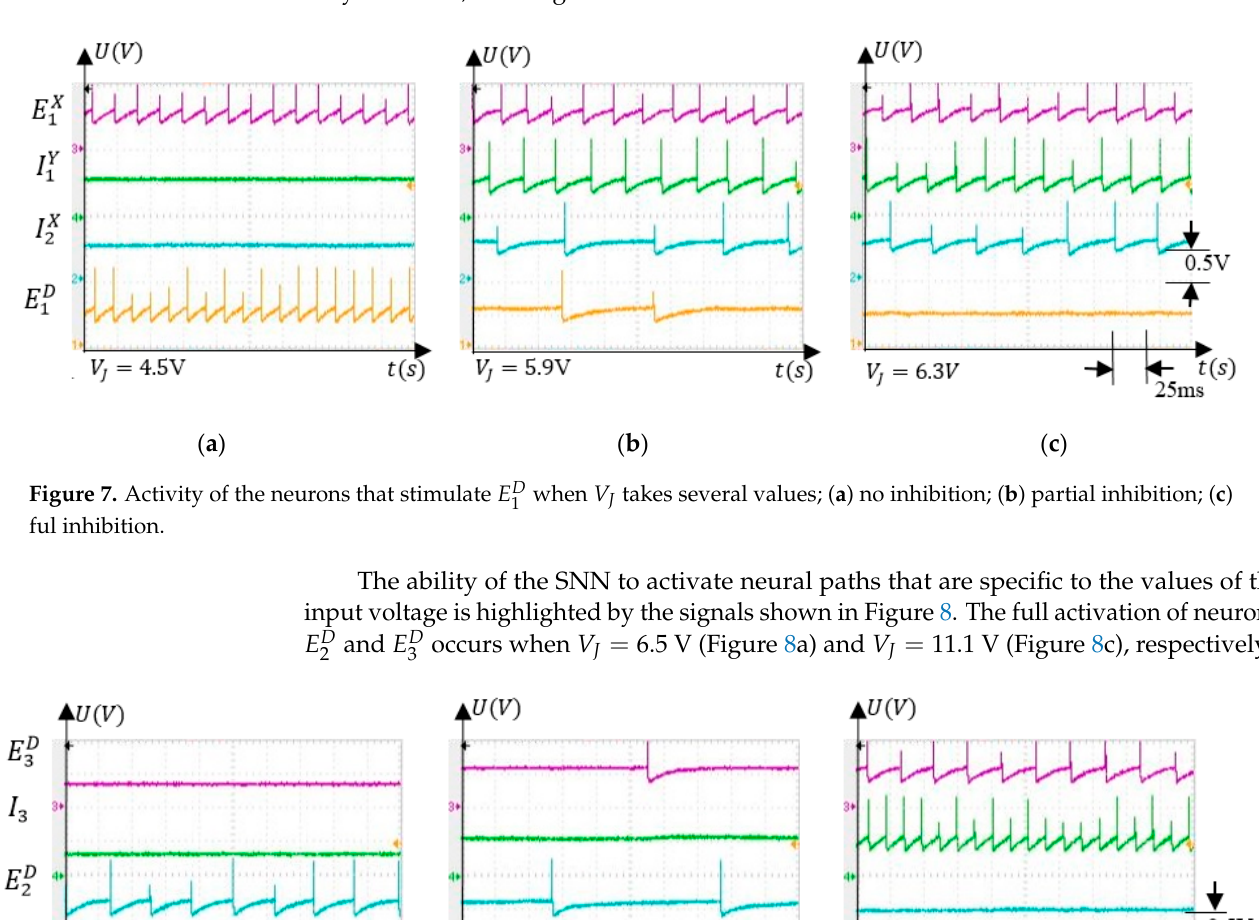
Figure 8. Neuron activity that shows the ability of the SNN to select which neural path to activate according to (cid:1848) (cid:3011) : ( a ) (cid:1831) (cid:2870)(cid:3005) and (cid:1835) (cid:2870) activated when the finger is in ∆(cid:2009) (cid:2870) ; ( b ) neurons from both neural paths are activated when the finger is between